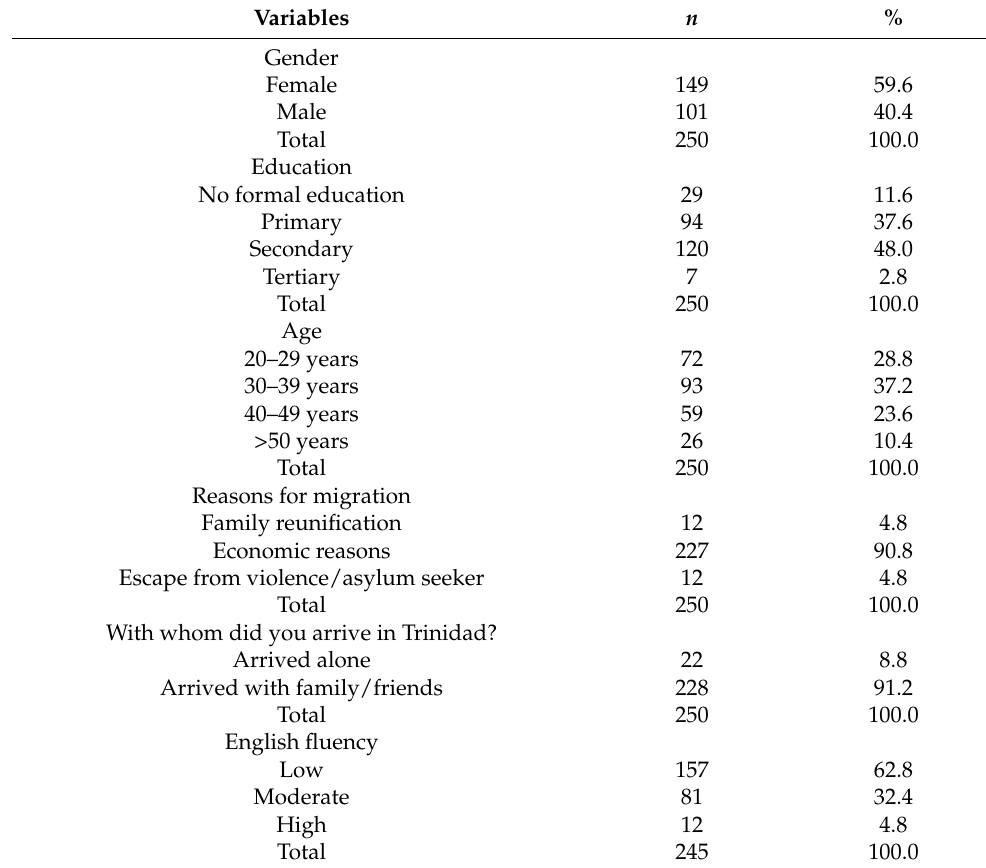
Table 1. Socio-demographic characteristics of